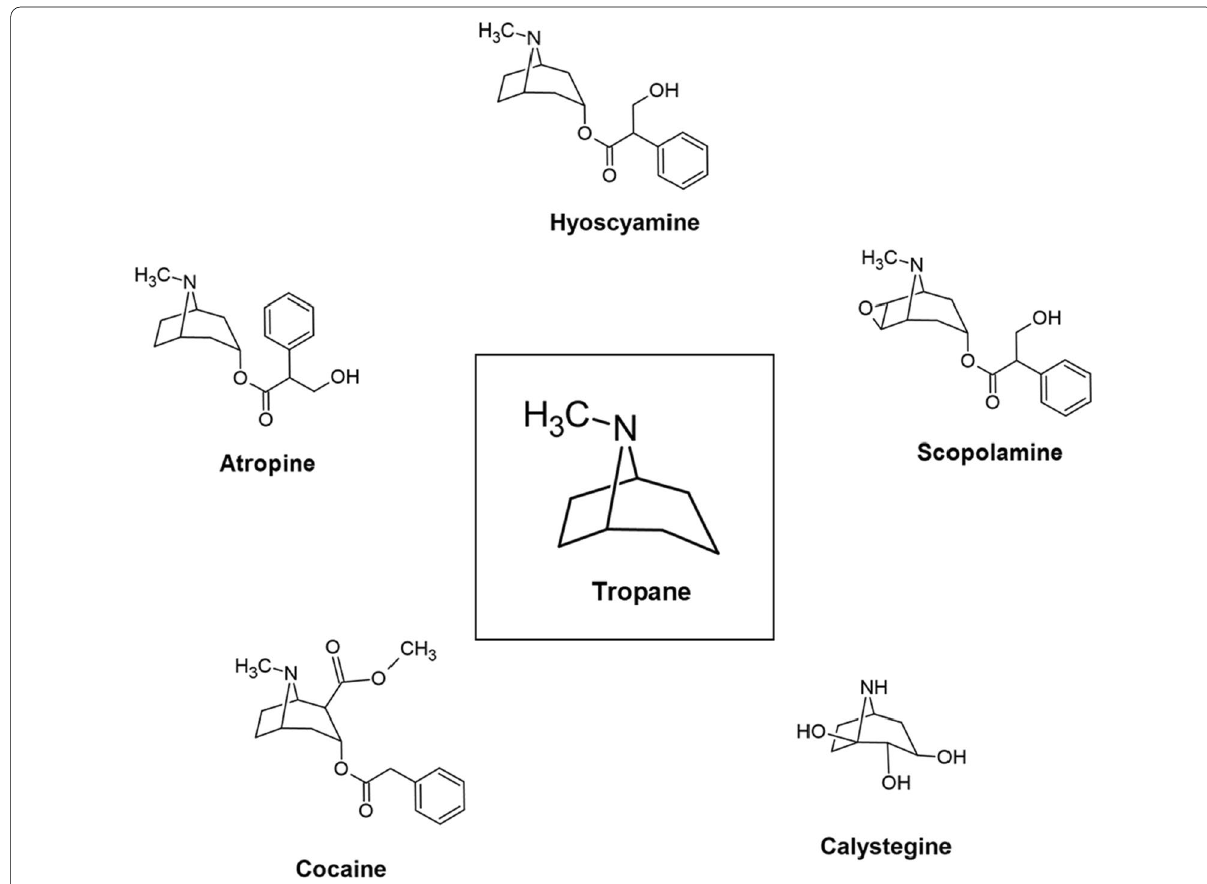
Fig. 2 Structure of natural tropane